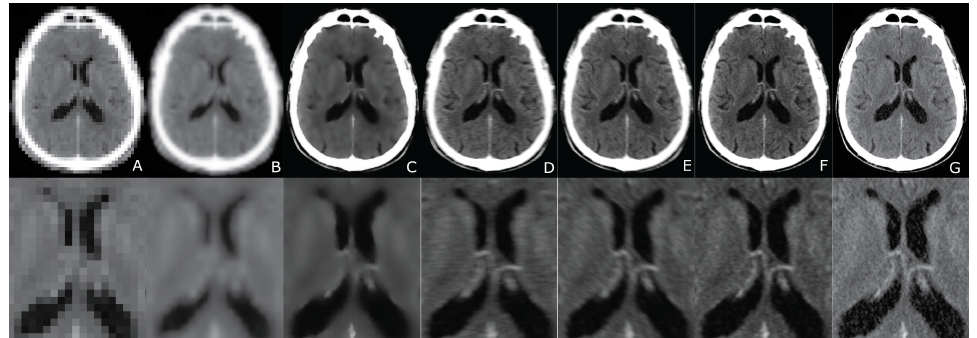
Figure 7. The performance of the presented algorithm for the data from Table 6. All the y -axes of the bee swarm plots represent PSNR values [dB].